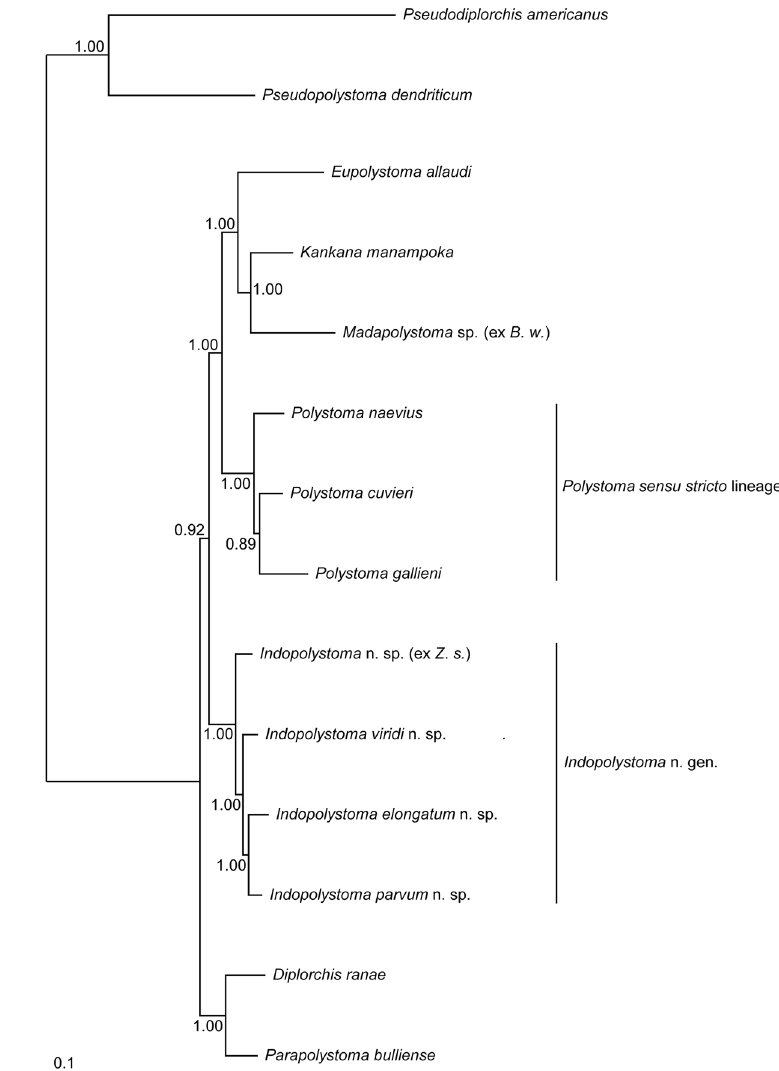
Figure 1. Bayesian tree for neobatrachian polystomes inferred from the analysis of four concatenated genes, namely 18S, 28S, COI and 12S. Numbers on nodes indicate Bayesian Posterior Probabilities. Indopolystoma spp. were regarded earlier as Polystoma spp. in Badets et al. [2] and Héritier et al. [22]. B. w. refers to Blommersia wittei and Z. s. to Zhangixalus smaragdinus . See also Table 1 for other host species. Scale bar represents 0.1